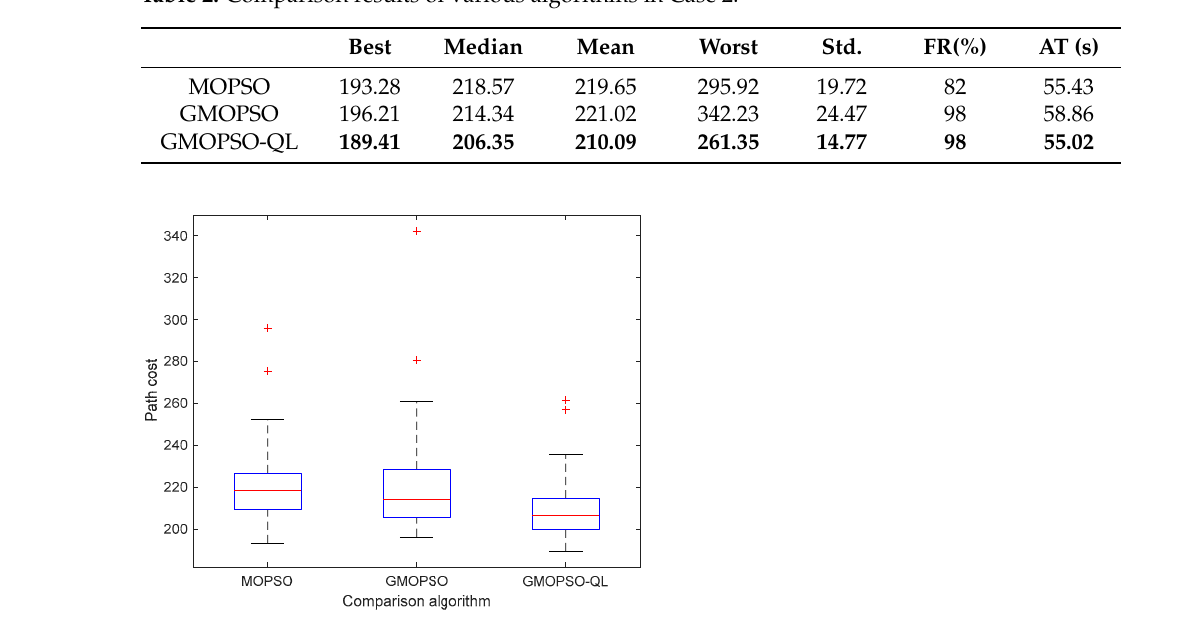
Table 2. Comparison results of various algorithms in Case 2.